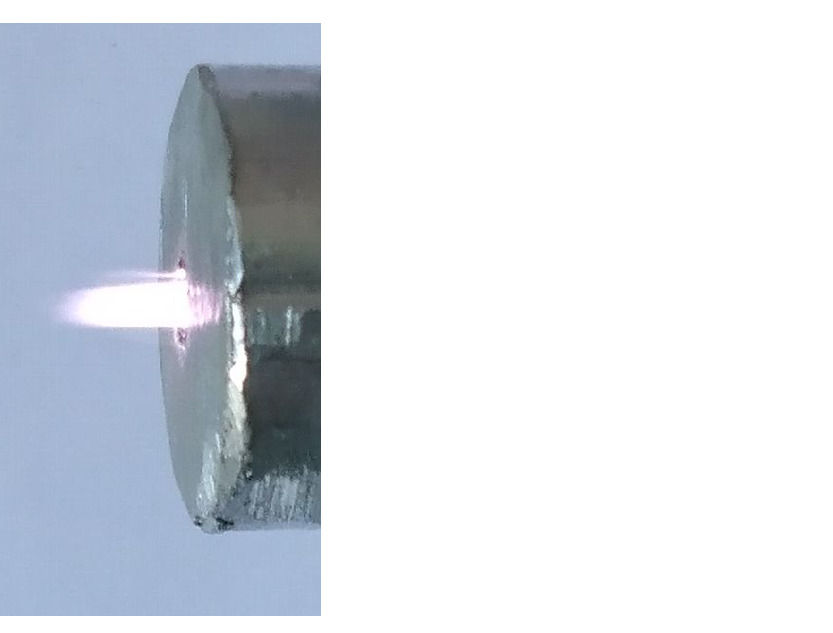
Figure 4. Plasma jet during normal operation. Experimental conditions: U i = 400 V rms , R b 2 = 20 k Ω , Ar as carrier gas at flow rate of 3